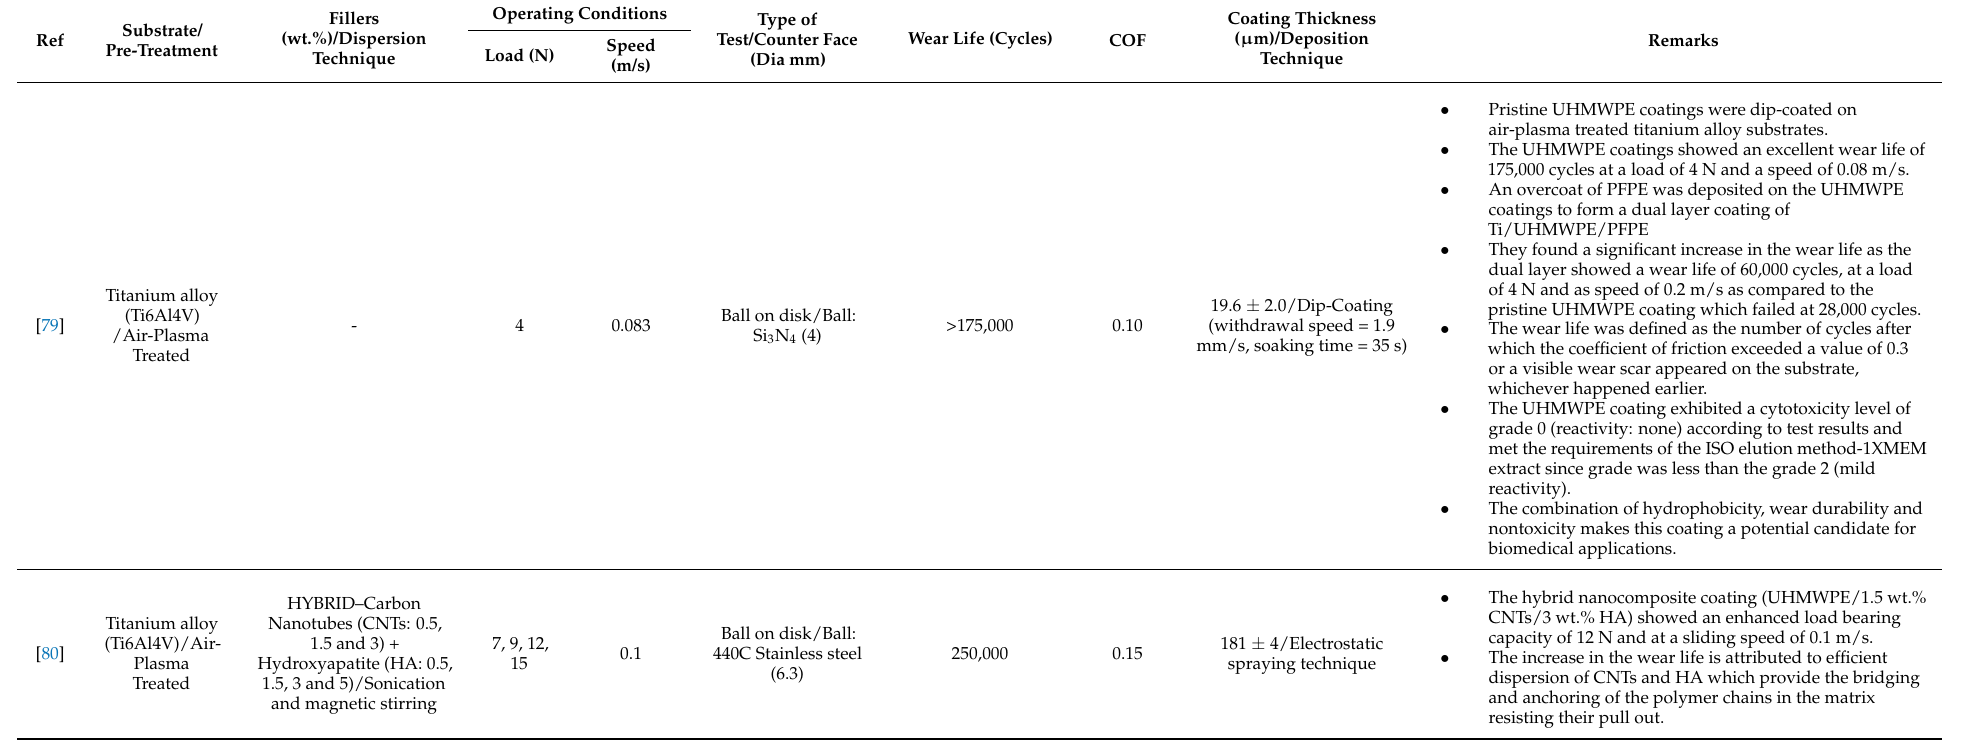
Table 9. Summary of the literature of UHMWPE coatings for bio-medical